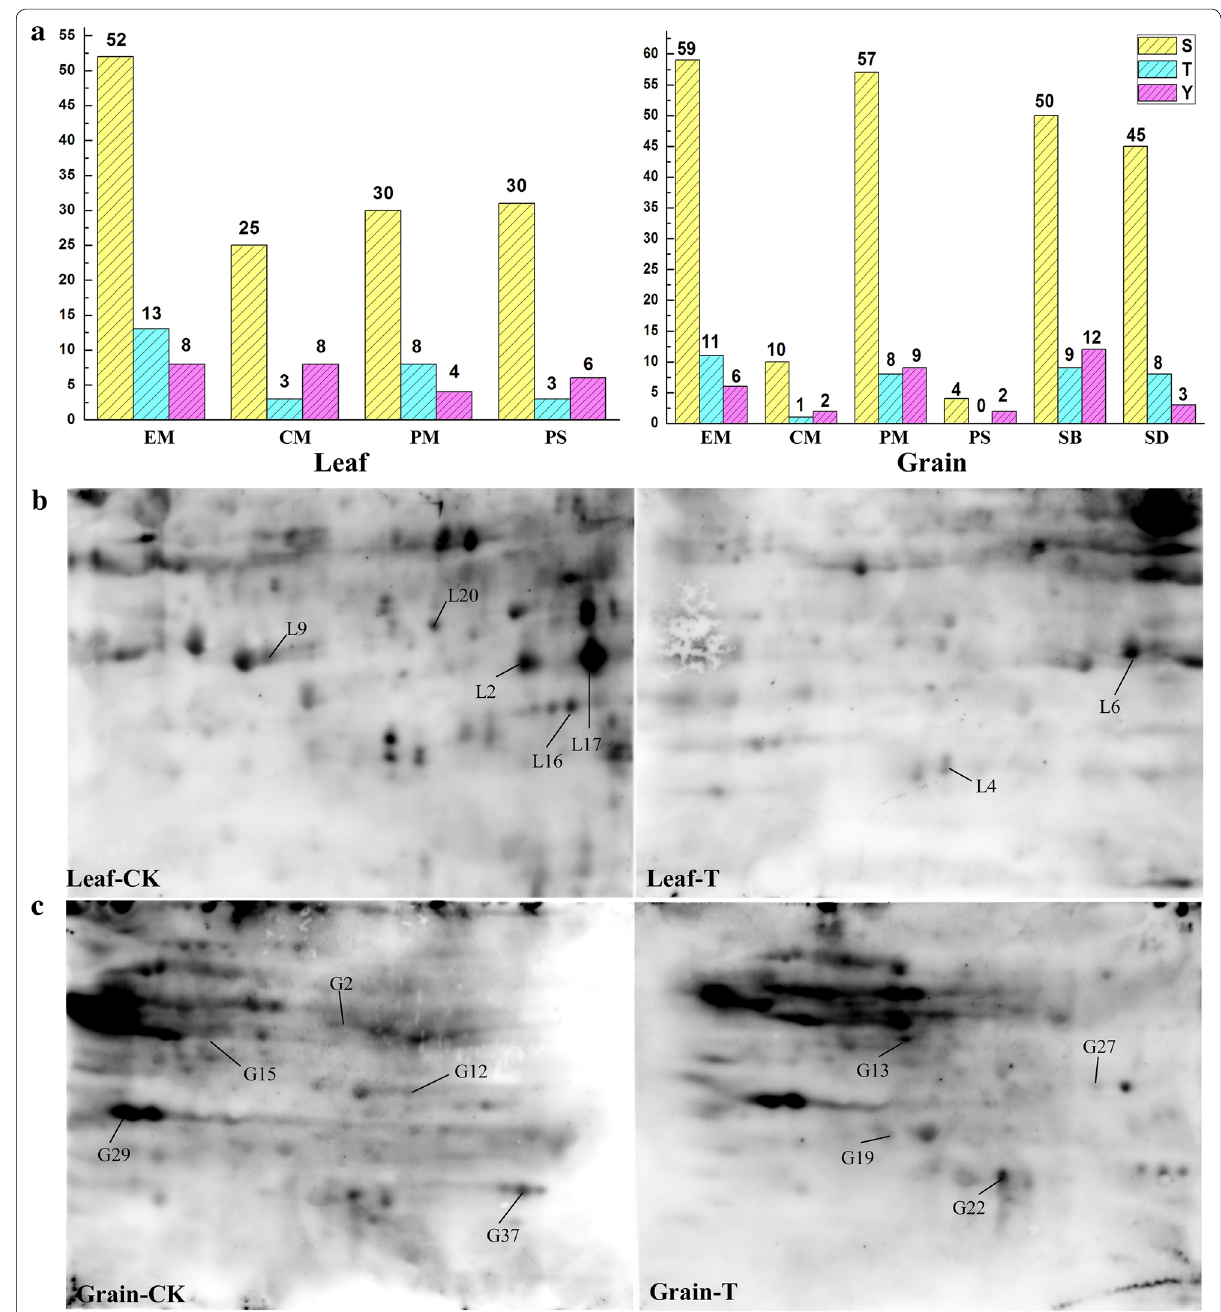
Fig. 7 Prediction of phosphorylated site by phosphorylation site software and verification of phosphoproteins by Western-blotting. a The numbers of serine/threonine/tyrosine predictive phosphorylation sites in main functional groups in flag leaf and grain. S: phosphosites in serine residues, T: phosphosites threonine residues, Y: phosphosites tyrosine residues. EM: energy metabolism; CM: carbon metabolism; PM: protein metabolism; PS: photosynthesis; SB: Starch biosynthesis; SD: stress defense. b Western-blotting analysis in leaves of CK and drought treatment group, respectively. c Western-blotting analysis in the grains of CK and drought treatment group. All the gels used to perform Western blotting were chosen from red box in Fig.